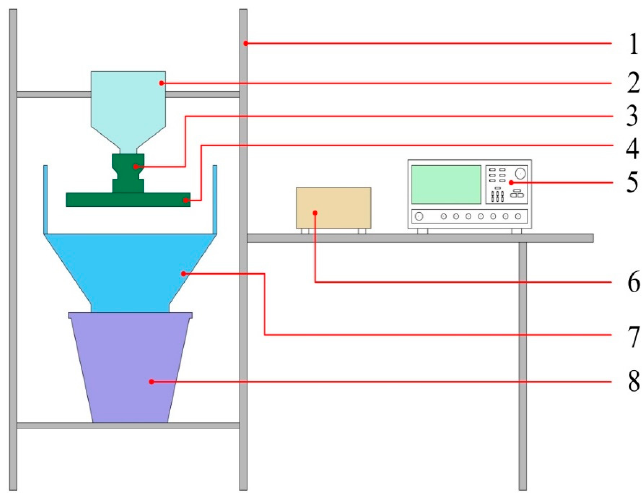
Figure 7. Schematic diagram of the bench test. 1. Support platform. 2. fertilizer box. 3.